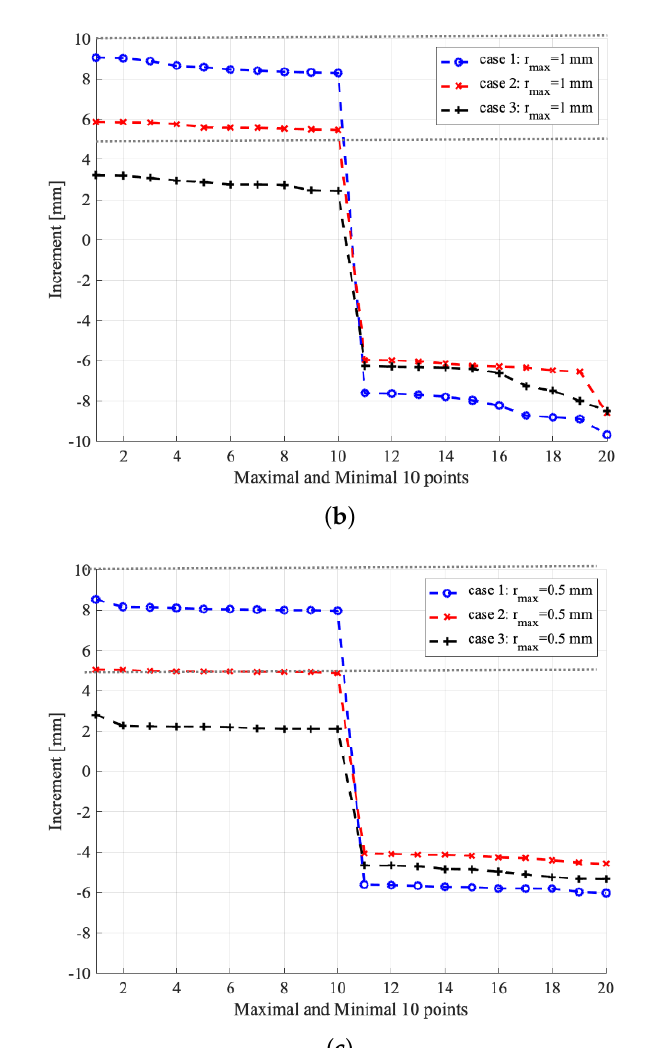
Figure 9. Maximal increase/decrease of surface height in the DEM simulations for Case 1 ( a ), for Case 2 ( b ) and for Case 3 ( c ): the value measured in the experiments represented by dotted lines (10 mm for Cases 1 and 2; 5 mm for Case